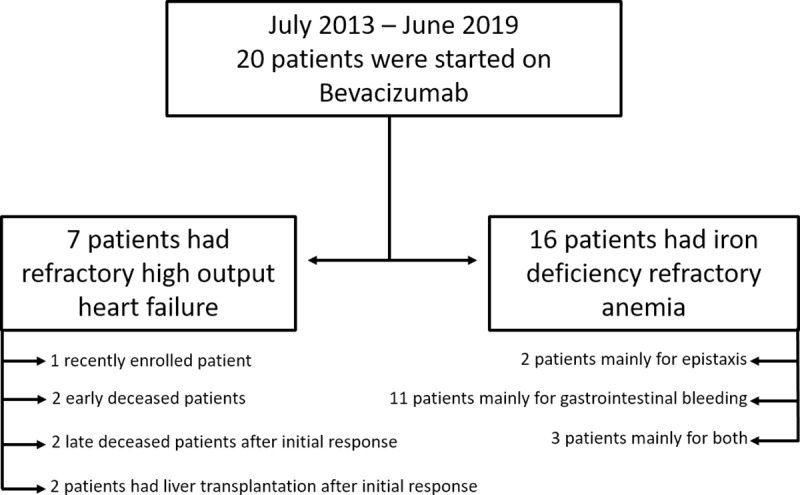
Study flow chart.